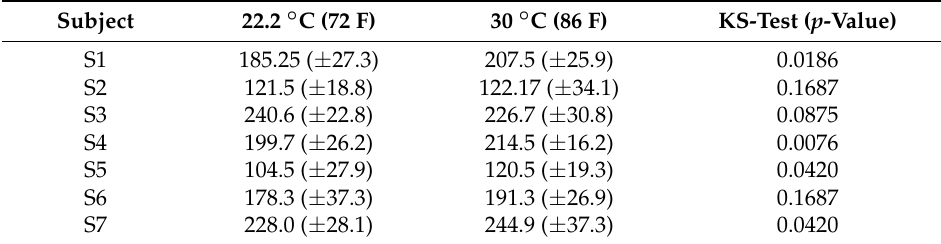
Table 2. KS test results on typing task performance under two indoor temperatures. Columns 2 & 3 show the average performance with standard deviation in parenthesis. Column 4 shows the p -values from the statistical